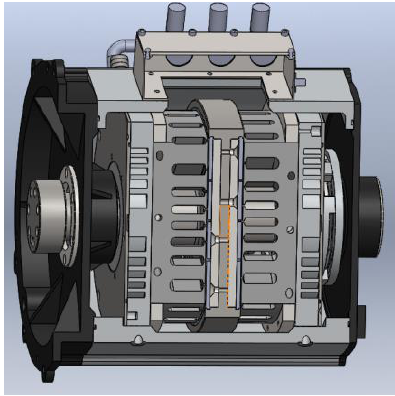
Figure 1. Double stator-single rotor type axial flux permanent magnet synchronous motor